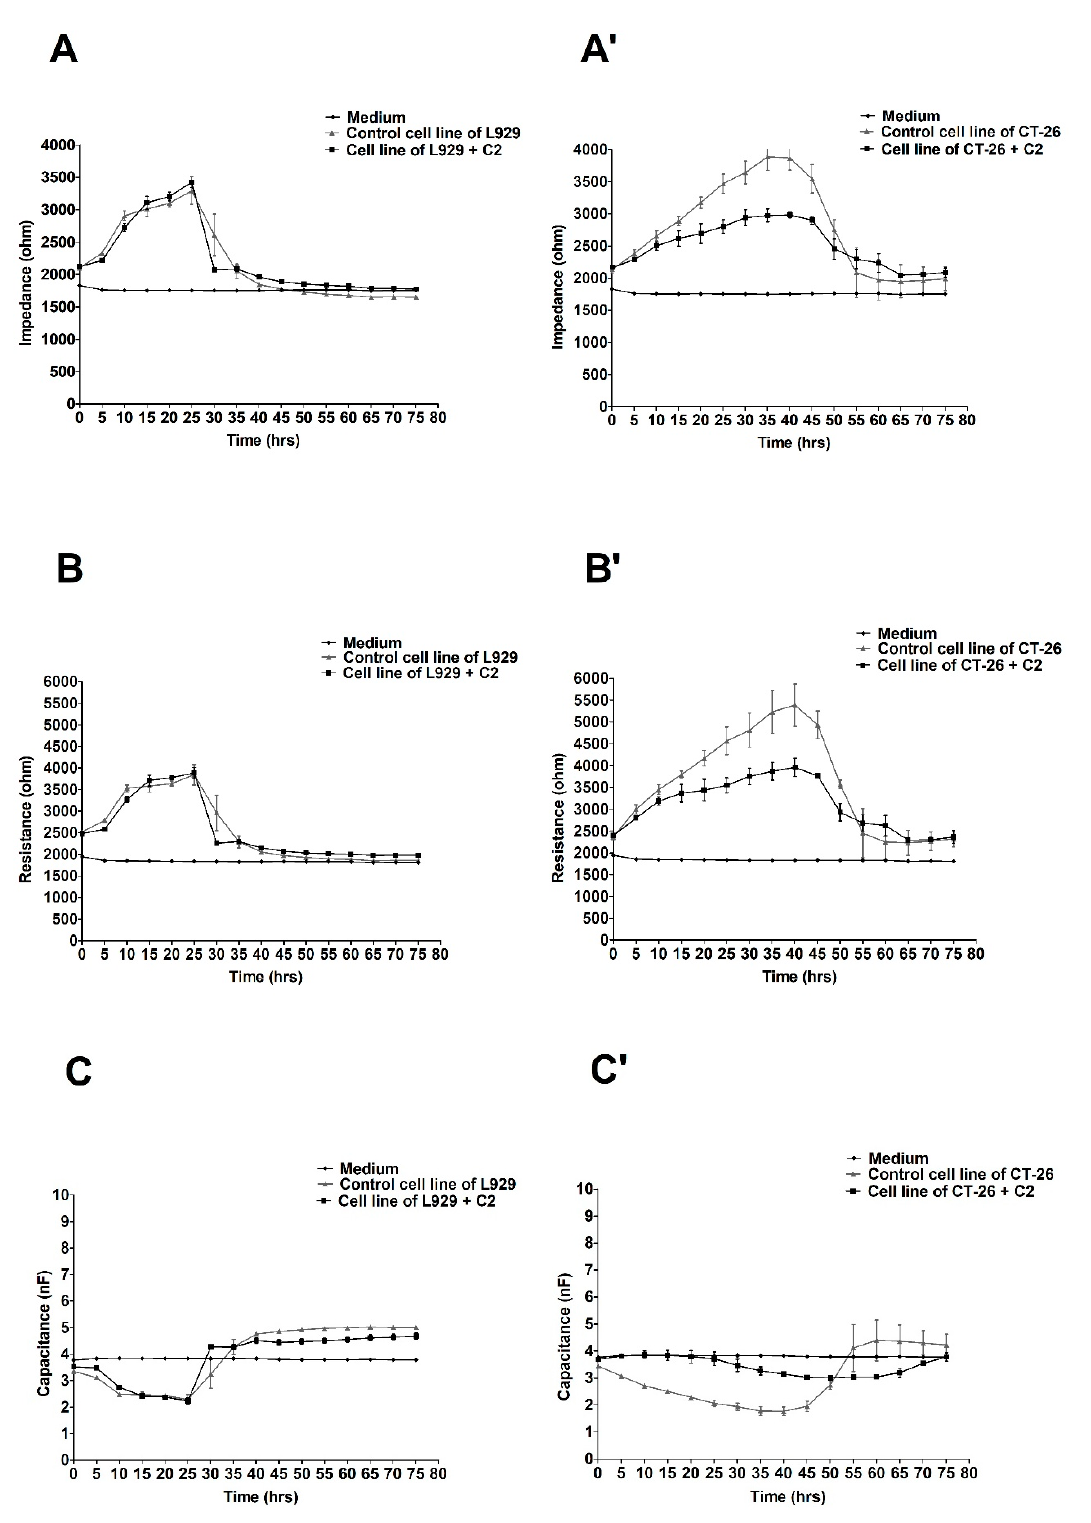
Figure 2. Impedance, resistance, and capacitance monitoring of the cell lines L929 ( A – C ) and CT-26 ( A’ – C’ ) during 80 h treatment with ex-LMS in concentration C2. The graphs show the course of impedance changes in L929 ( A ) and CT-26 ( A’ ) cultures after treatment with ex-LMS at a concentration of C2 (22.85 µ g/mL); resistance changes in L929 ( B ) and CT-26 ( B’ ) cultures after treatment with ex-LMS at a concentration of C2 (22.85 µ g/mL); and capacitance changes in L929 ( C ) and CT-26 ( C’ ) cultures after treatment with ex-LMS at a concentration of C2 (22.85 µ g/mL). Data are presented as mean value ±